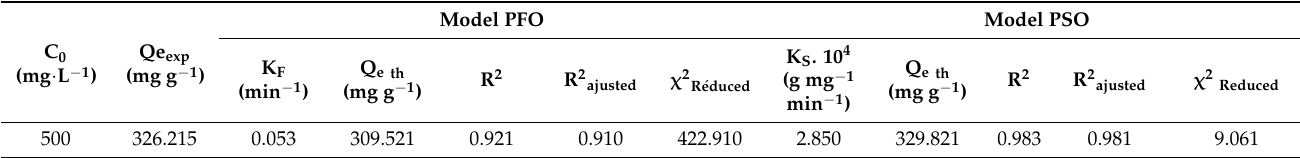
Table 2. Pseudo-first-order and pseudo-second-order parameters of MeO adsorption on MO C-ZnCl